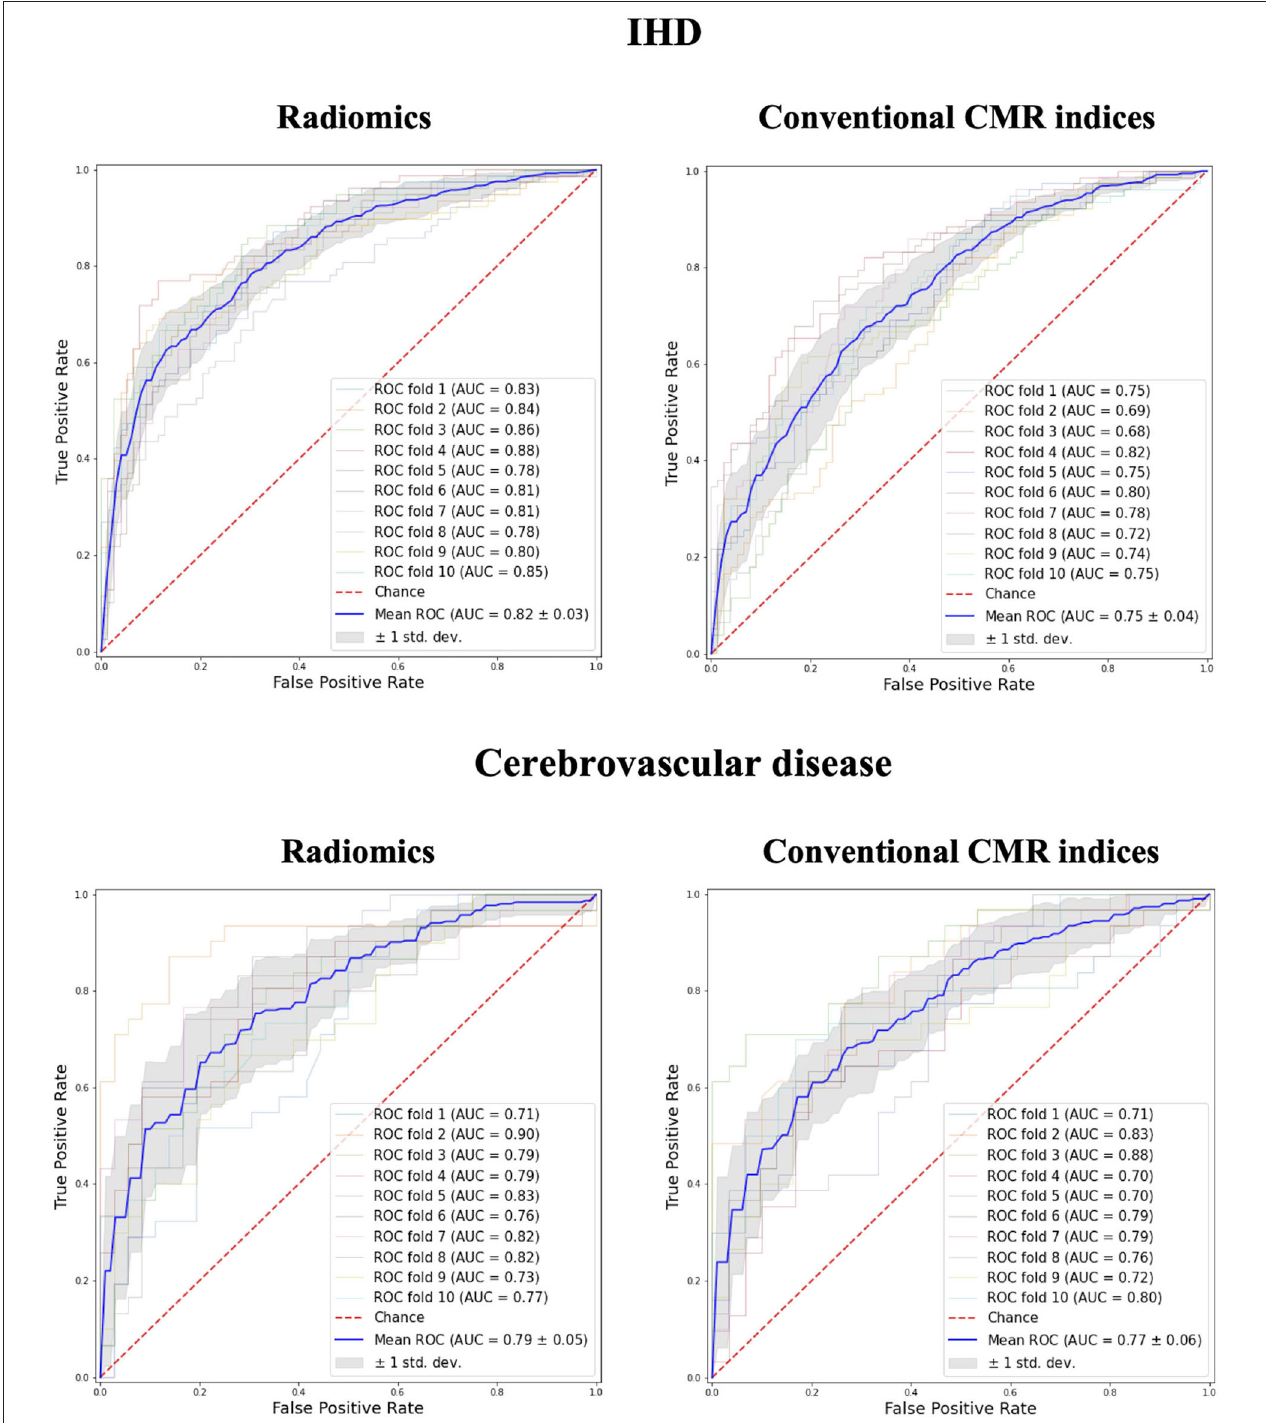
FIGURE 2 | Receiver operating curves for radiomics vs. conventional CMR indices models in IHD and Cerebrovascular Disease groups. IHD, ischaemic heart disease; AUC, Area under the curve.